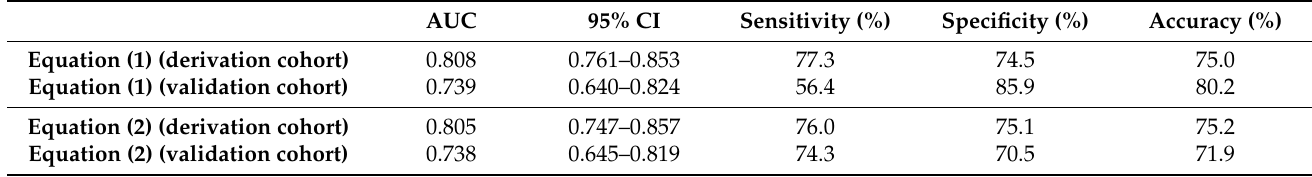
AUC, area under the receiver operating characteristic curve; CI, confidence interval.